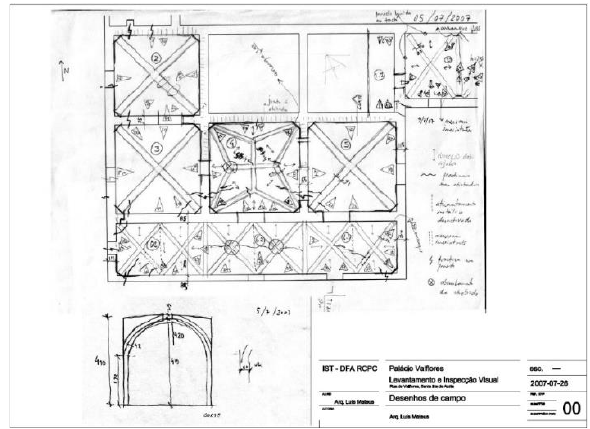
Figure 3. Using existing plans from DGEMN as support for annotations.